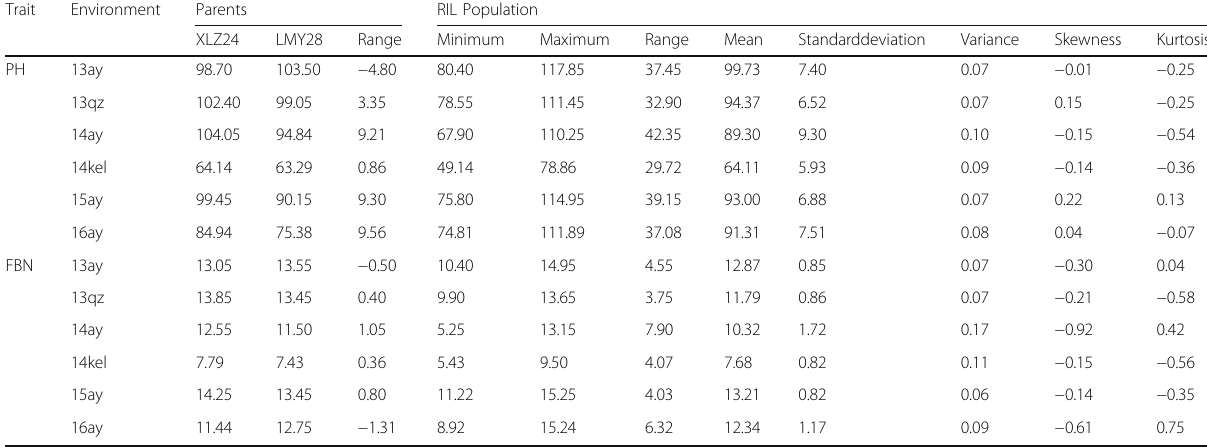
Table 2 The descriptive statistical analysis of the parents and the recombinant inbred lines (F 6:8 ) population Trait Environment